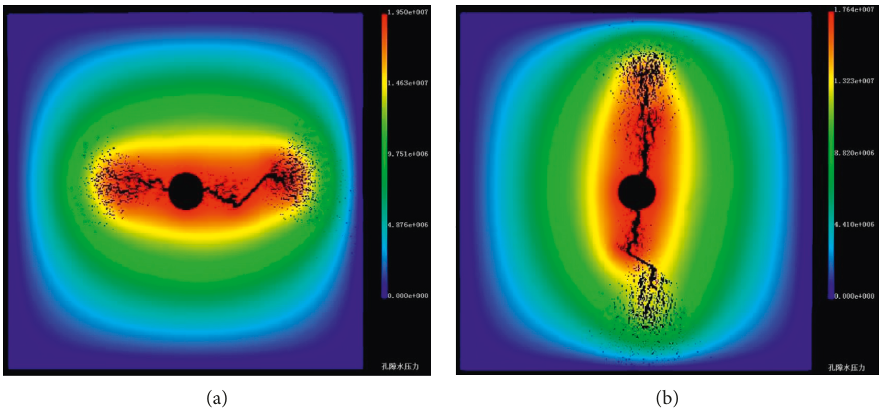
Figure 11: Pore pressure field of multijoint models. (a) σ